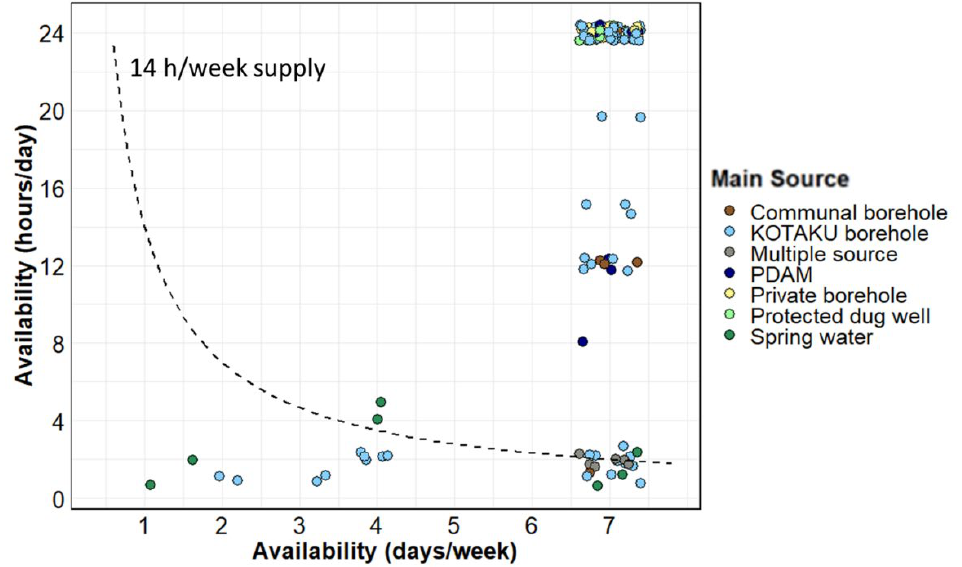
Figure 5. Supply frequency and hours of different water sources (The dashed line indicates supply hours of 14